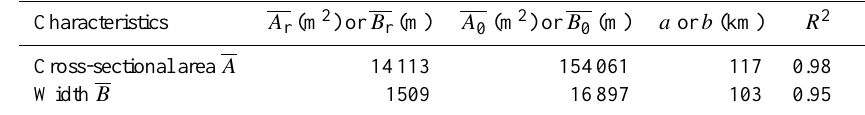
Table 2. The geometric characteristics of the Yangtze estuary.